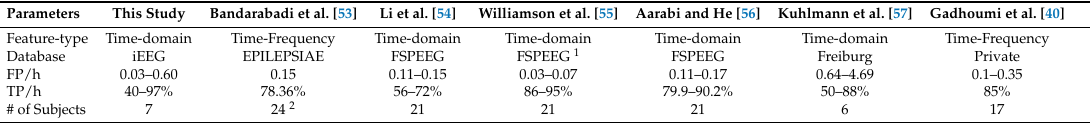
Table 18. Comparison of our study with existing